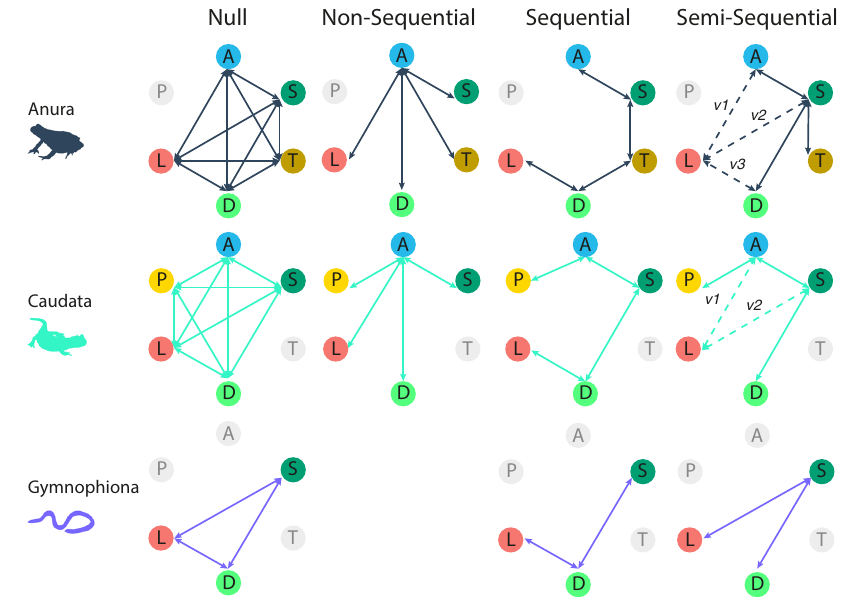
Fig. 2 | Schematics of four scenarios of reproductive-mode evolution. Null: transitions between all states (reproductive modes) can occur. Non-sequential: derived (more terrestrial) states can only transition to and from the ancestral aquaticmode.Sequential:transitionscanonlyoccurbetweentheecologicallymost similar states. Semi-sequential: derived, fully terrestrial modes (direct develop- ment,livebearingandfullyterrestrialbiphasic)canonlytransitiontoand fromthe semi-terrestrial mode. Up to three variations of this fi nal scenario were tested (dashed lines), allowing live-bearing to transition either to and from the aquatic